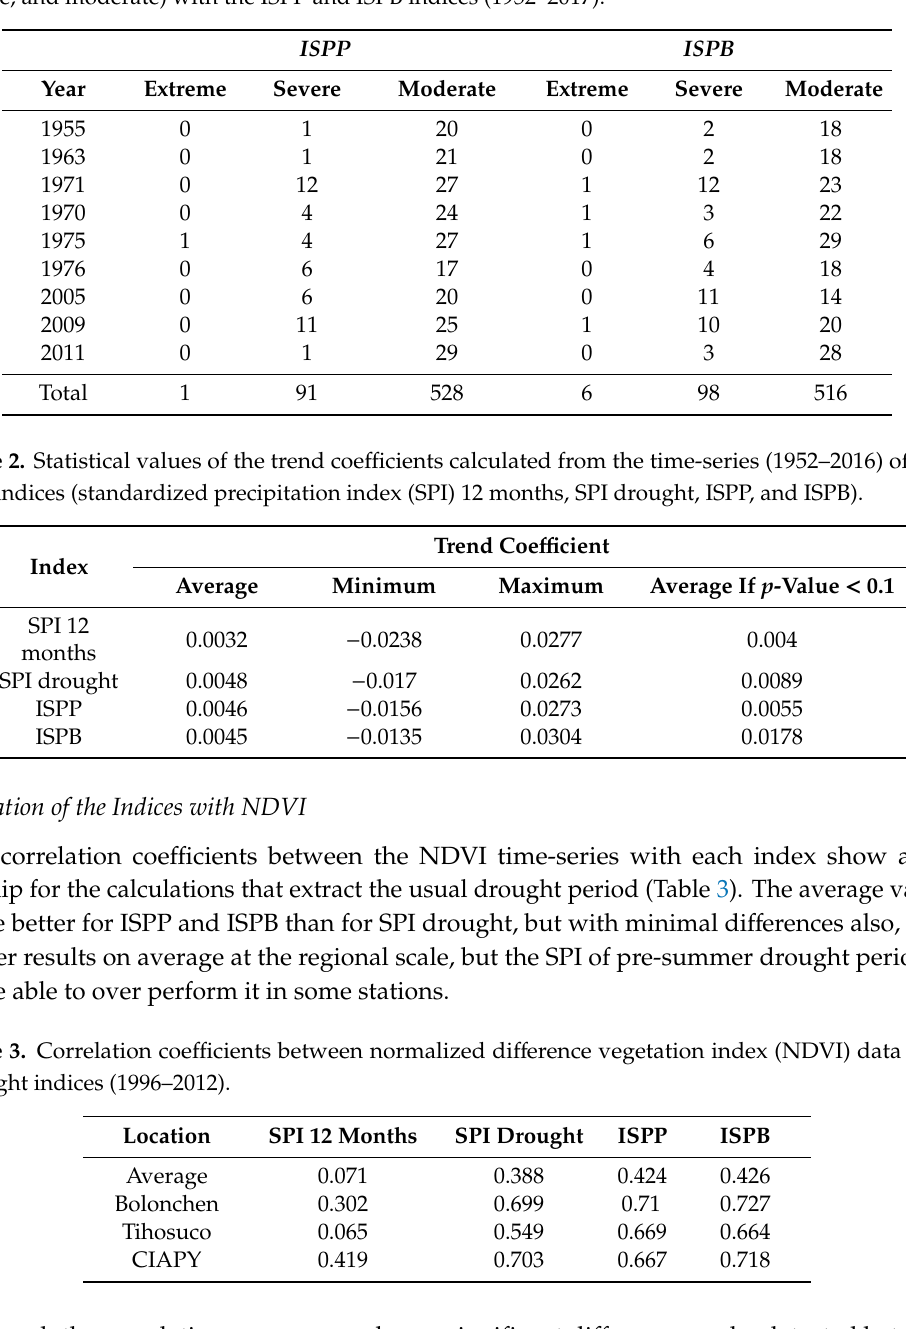
Table 1. Grand total and years of greatest occurrence of the three highest levels of drought (extreme, severe, and moderate) with the ISPP and ISPB indices (1952–2017).